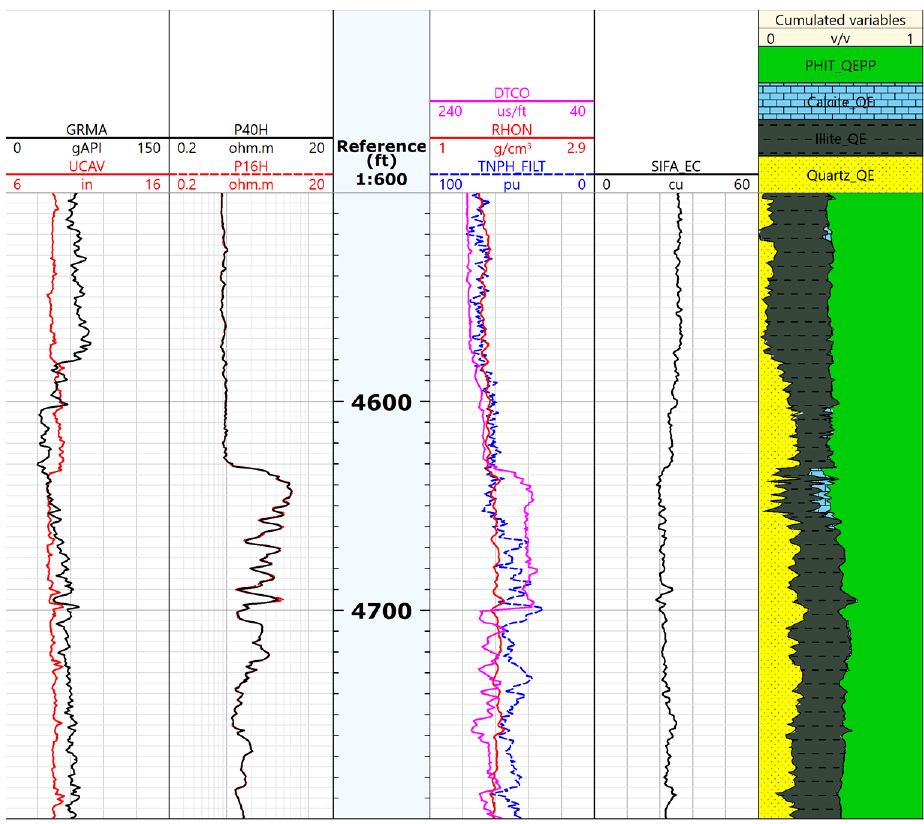
Figure 5. Well W3 ′ s logging curve and measured sigma value. Figure 5. Well W3’s logging curve and measured sigma